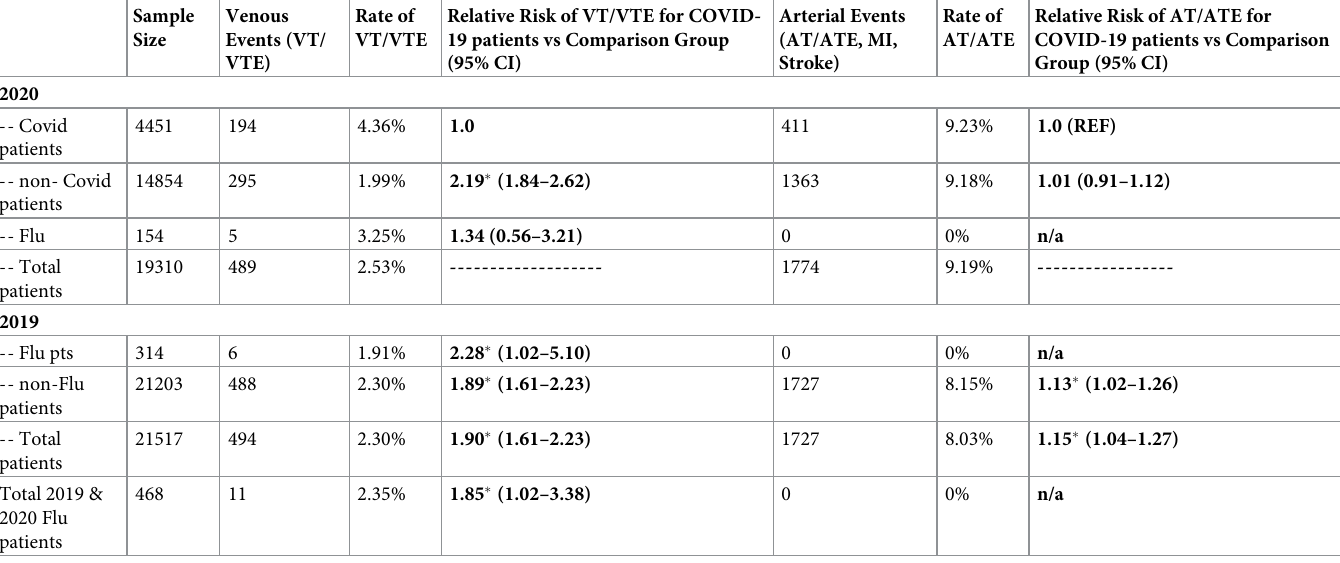
Table 2. Rates and risk ratios of venous and arterial thrombosis in COVID-19 vs non-COVID patients. Sample